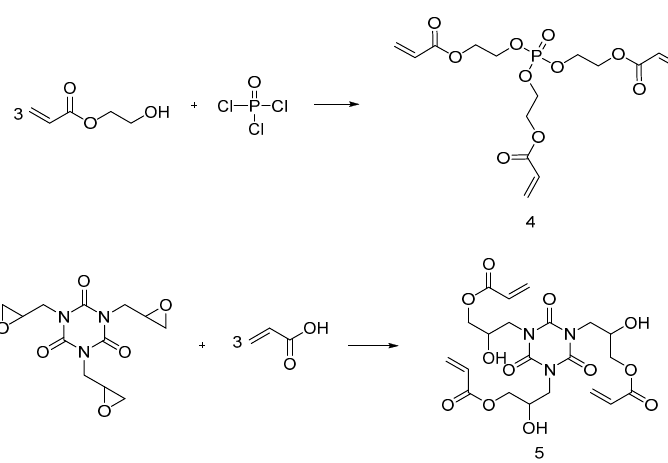
Figure 5. Schematic synthesis of UV-curable monomers ( 4 ) and ( 5 ).